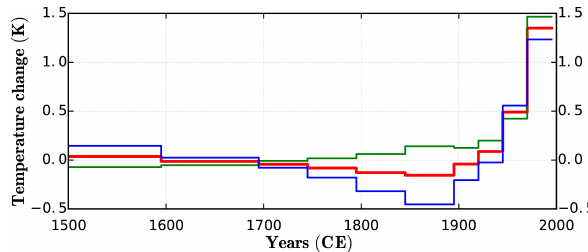
Figure 2. Ground surface temperature history for CA-9519 (Fox Mine, 1995). The red line represents the GST history reconstructed from inversion. The blue and green lines are the GSTs for the anomalies estimated from the 95% uncertainty limits of the quasi- steady-state